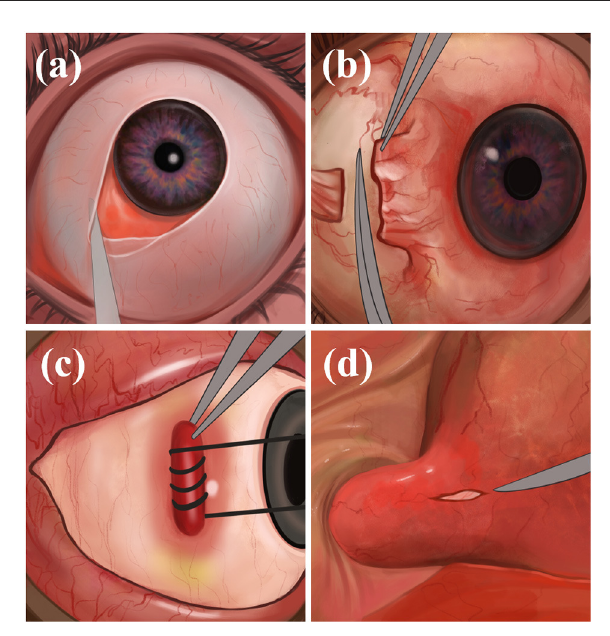
FIGURE2 The medial conjunctival approach: (a) Incise the bulbar conjunctiva along the nasal limbus, bluntly separate the bulbar conjunctiva and fascial tissue; (b) expose and separate the medial rectus muscle; (c) immobilize the internal rectus muscle; (d) expose the optic nerve sheath and make an